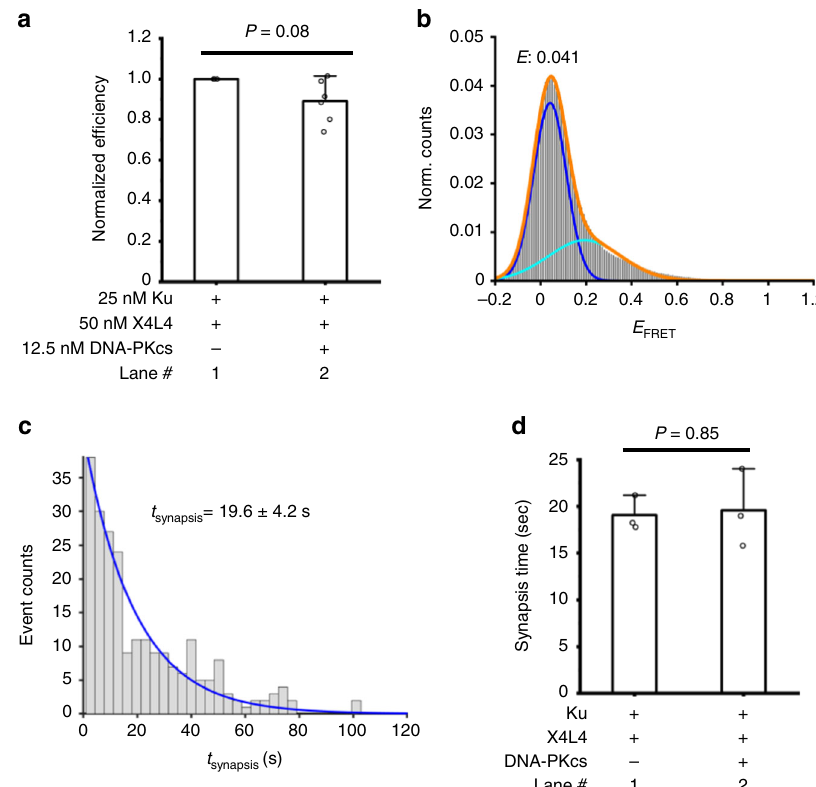
Fig. 2 DNA-PKcs has little effect on synapsis mediated by Ku plus X4L4. a Normalized synapsis ef fi ciency mediated by different NHEJ factors − 25 nM Ku, 50 nM X4L4, and 12.5 nM DNA-PKcs using the glucose plus gloxy oxygen scavenger system. Data are represented as mean ± SD of at least four independent replicates. T -test (unpaired, two-tailed) was applied for p value calculation ( p = 0.08). b Histogram of E FRET values of all synapsis events mediated by 25 nM Ku, 50 nM X4L4, and 12.5 nM DNA-PKcs using the glucose plus gloxy oxygen scavenger system in the solution. The E value shown